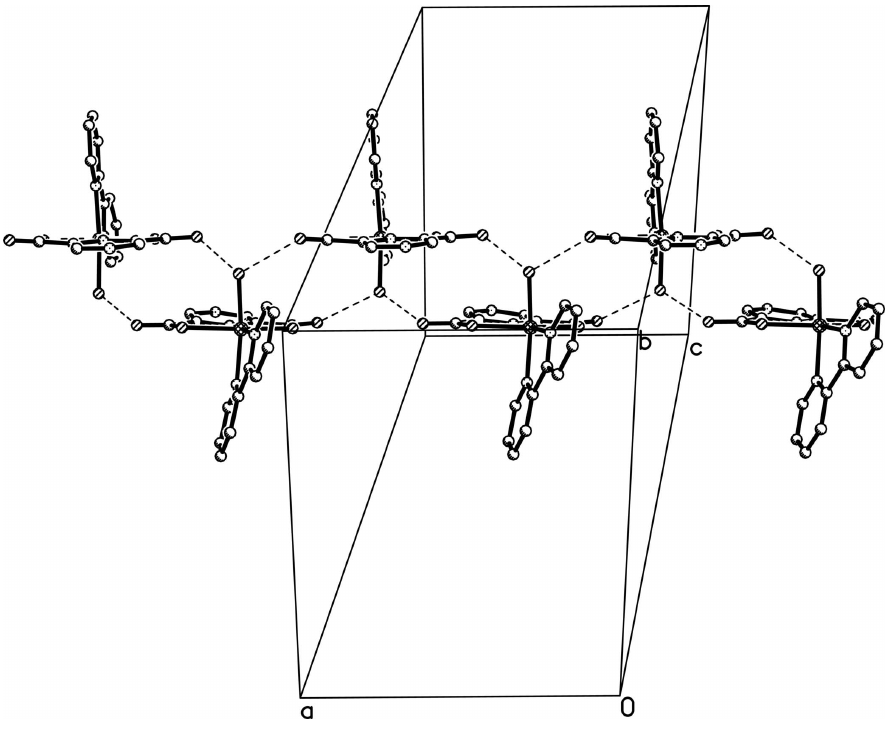
Figure 2 Part of the crystal structure of the title compound. Dashed lines indicate the donor-acceptor separation of O-H···O hydrogen bonds. The solvent water molecules are not